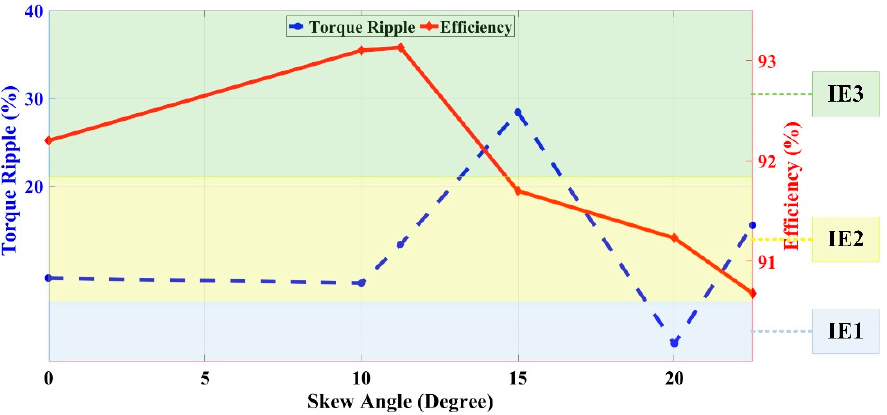
Figure 8. Efficiency and torque results of AFIM with 32 slots.